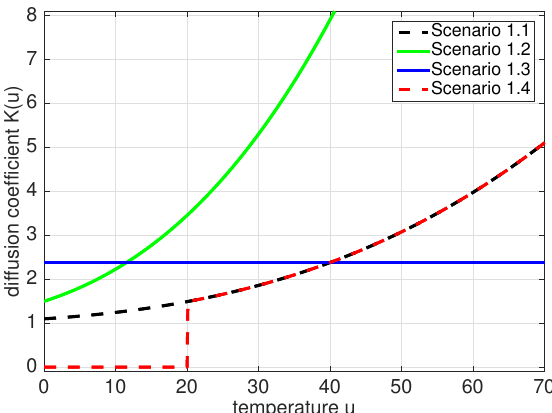
Figure 1. Scenarios 1.1 to 1.4: diffusion coefficients K ( u ) .